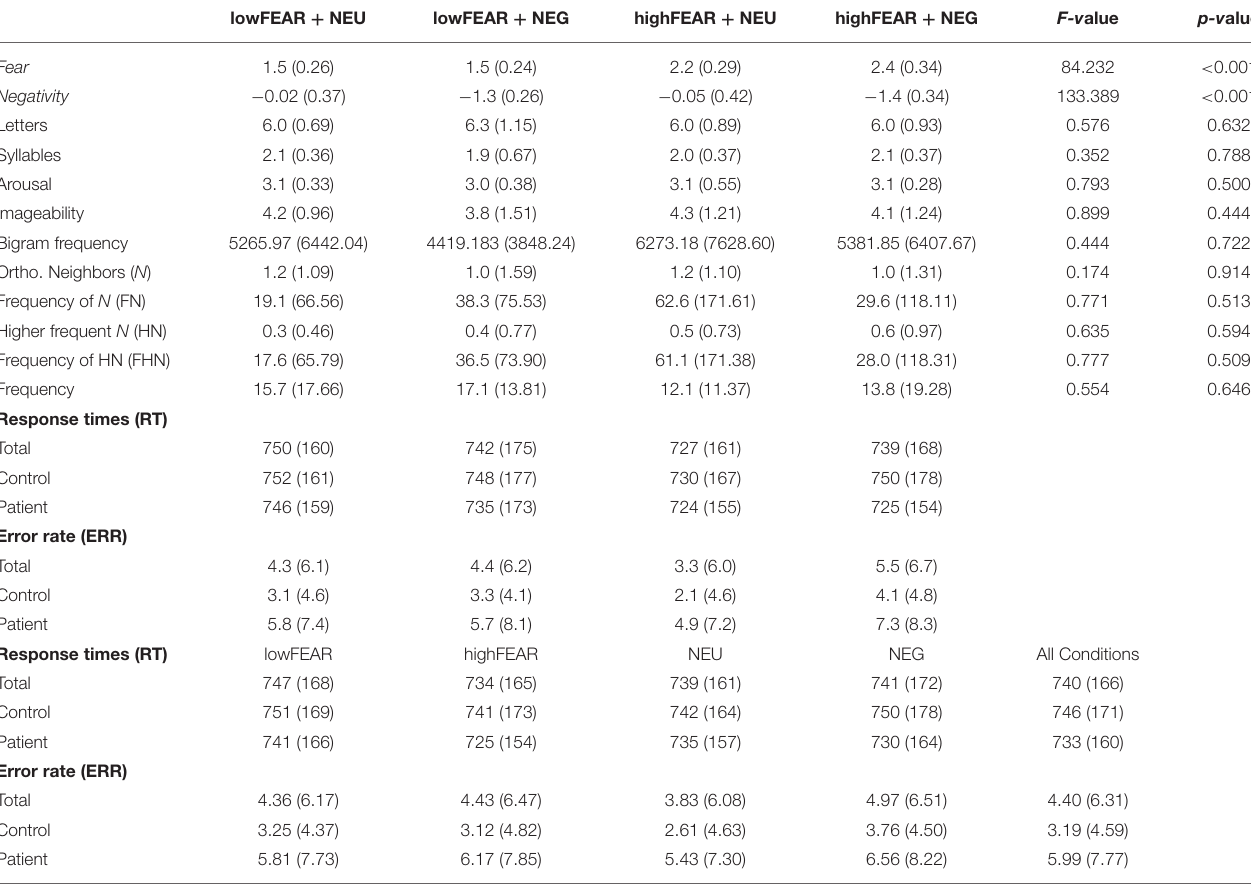
TABLE 1 | Descriptive statistics of the stimulus set, along with the behavioral